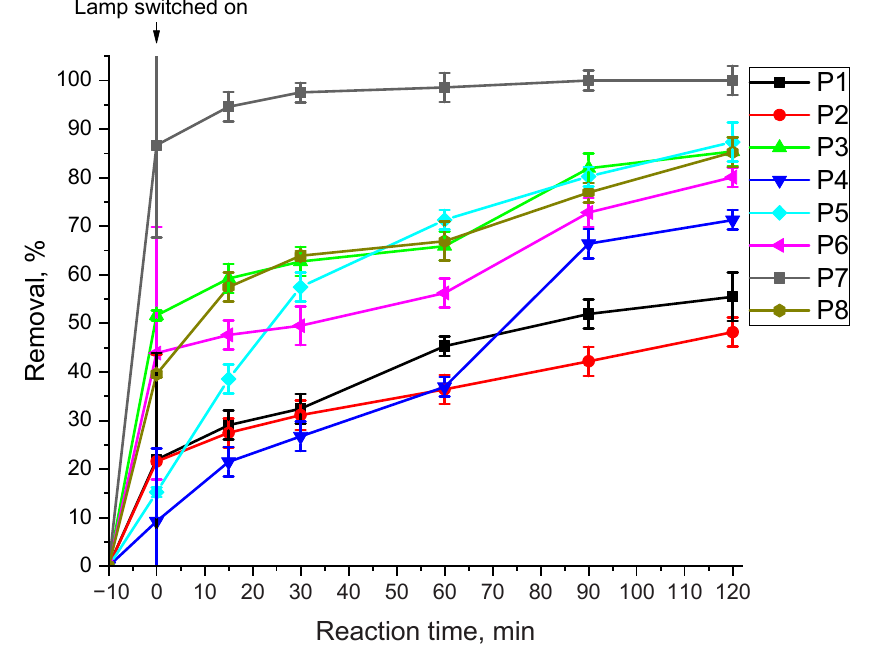
Figure 6. Removal of ampicillin from water solution using a solar simulator as irradiation source. The photo-irradiation of the system changed the order established by the